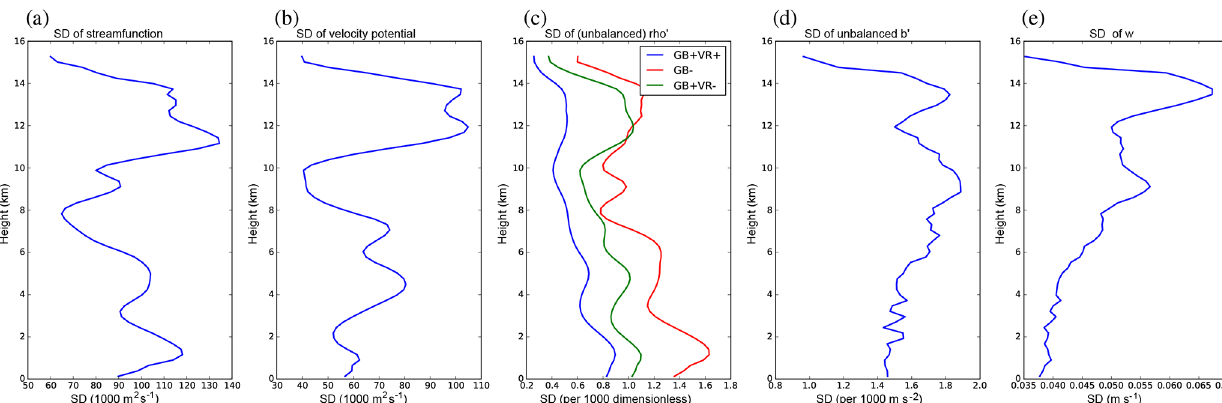
Figure 3. Profiles of background error standard deviations for the five control parameters with height: (a) streamfunction δ ψ , (b) velocity ˜ ρ (cid:48) u , (d) unbalanced buoyancy δ b (cid:48) u , and (e) vertical wind δ w . The blue lines are for the potential δ χ vp , (c) unbalanced scaled density δ experiment described in the text – namely GB and VR are switched on in the parameter transform. In panel (c) the red line is for the experiment with GB (and hence VR) switched off, and the green line is for the experiment with GB switched on and VR switched off. In the other panels all experiments yield the same profiles. The values have been smoothed using a running average over the nearest five